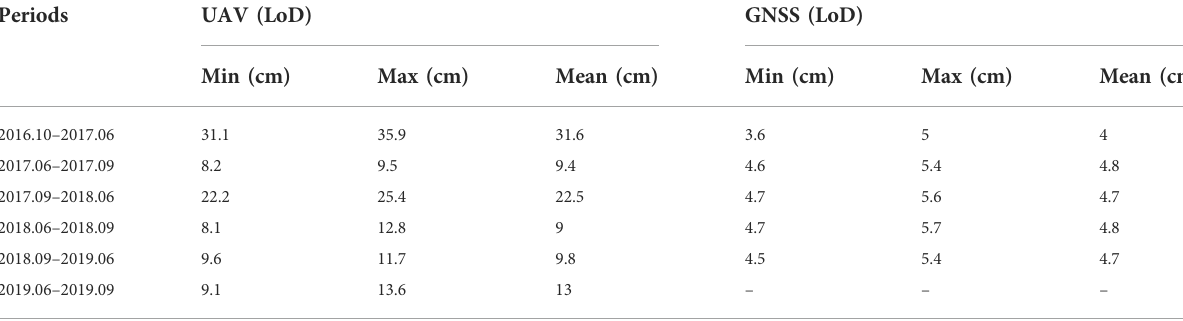
TABLE 4 Information on the minimum (Min), maximum (Max) and mean LoD (con fi dence limit of 90%) for each period. Periods UAV